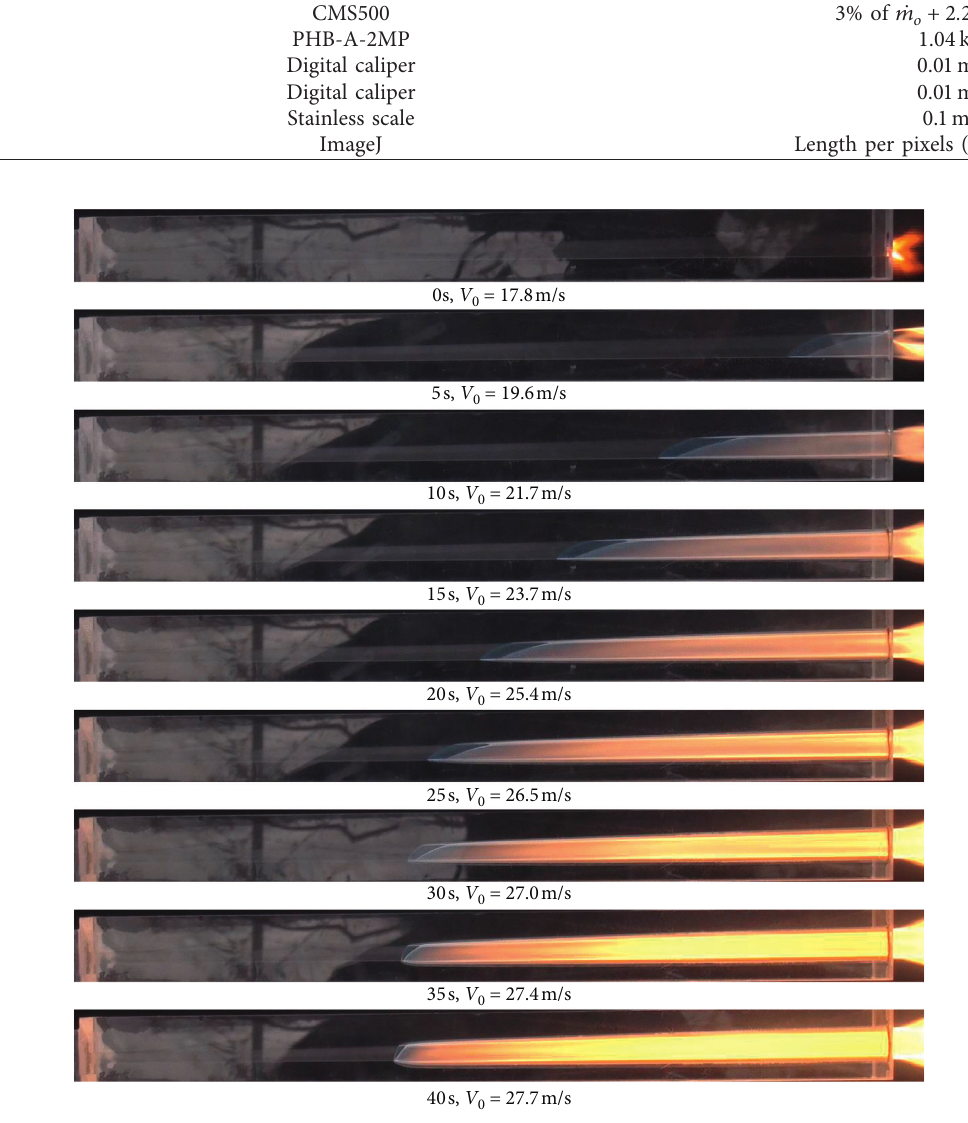
Figure 5: Typical images of the flame (Test 6). Table 4: Firing